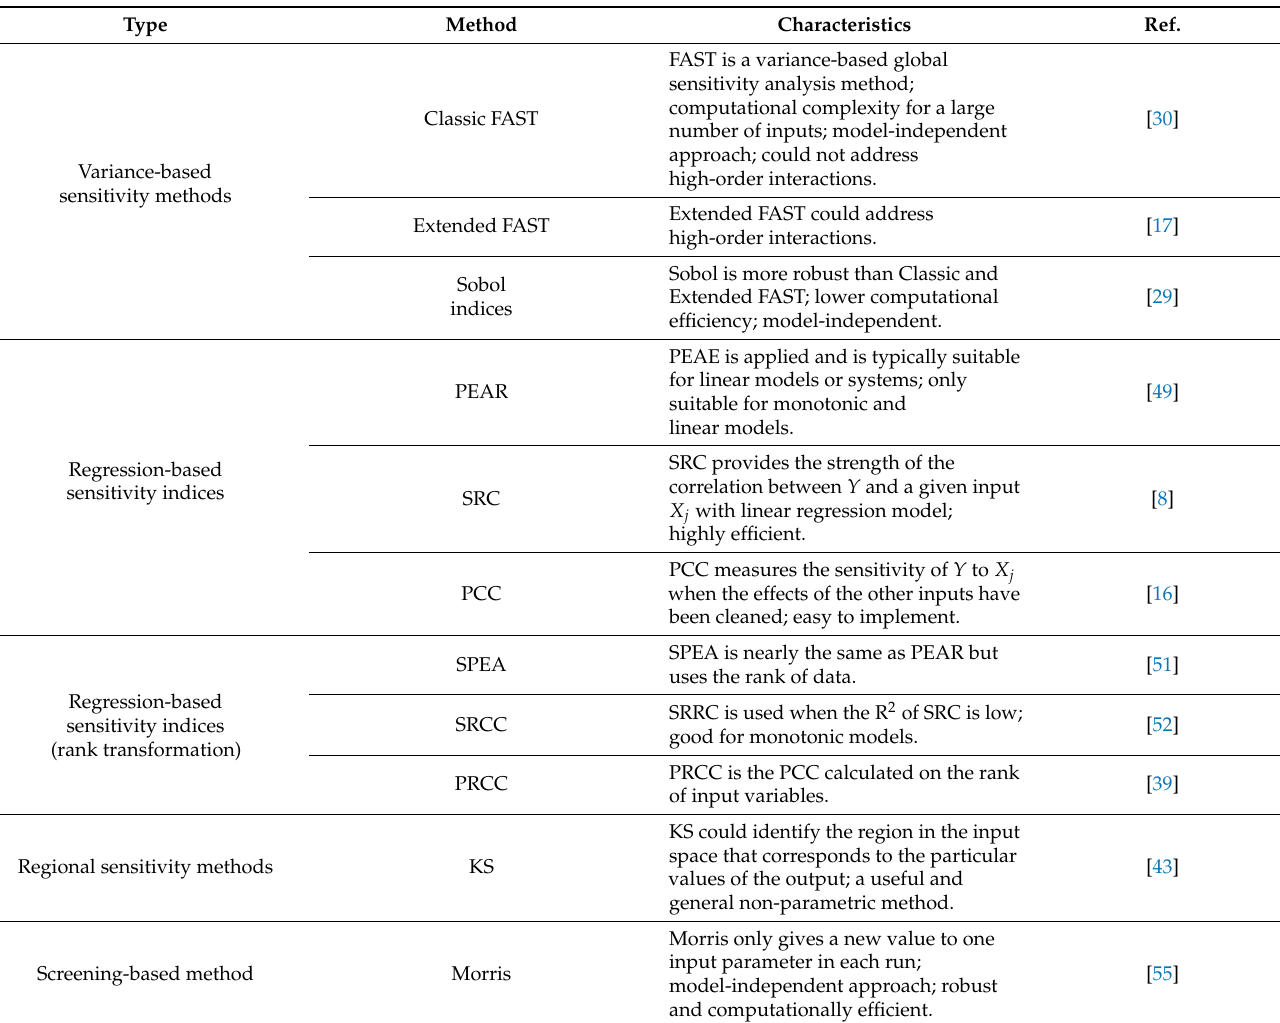
Table 1. The characteristics of each SA method in this